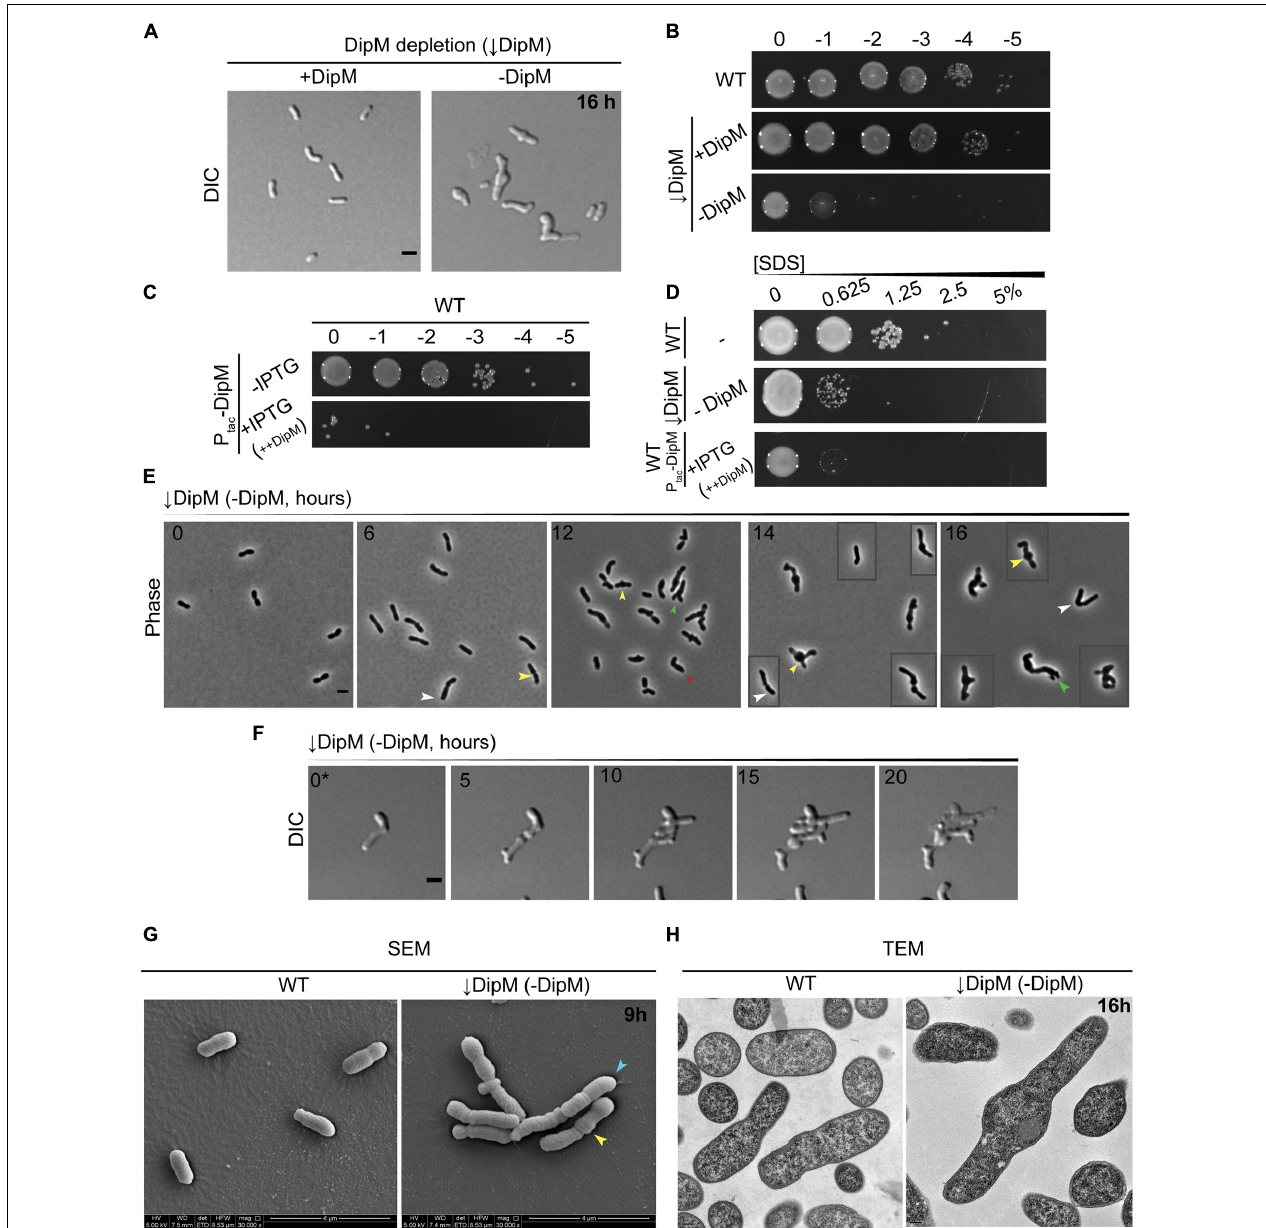
FIGURE 5 | dipM is essential in A. tumefaciens and depletion results in mid-cell bulging, inhibition of division, and ectopic pole formation. (A) DIC imaging of DipM replete ( ↓ DipM, +DipM; grown in the presence of IPTG) and depleted cells ( ↓ DipM, –DipM) for 16 h. Depletion of DipM ( ↓ DipM, –DipM) was achieved by washing the cells three times in LB and resuspending the culture (OD600 ∼ 0.1) in LB –IPTG. DipM depletion in LB results in mid-cell bulges and cell lysis. Scale bar = 2 µ m. (B) Spot viability assays of WT, DipM replete ( ↓ DipM, + DipM) and DipM depleted ((DipM, − DipM). Depletion of DipM ( ↓ DipM, –DipM) was achieved by washing the cells three times in LB before spotting on LB plates. (C) Spot viability assays of WT cells containing a plasmid encoded DipM under the control of the Ptac promoter in the absence (–IPTG, uninduced) and presence [+IPTG, induced (++DipM)] of inducer driving expression from the plasmid. ++DipM indicates that DipM is being overproduced. (D) Outer membrane integrity was assessed during SDS sensitivity. WT cells are more resistant than the DipM depletion ( ↓ DipM, –DipM) or DipM overproduction (+IPTG, ++DipM) strains. DipM was overexpressed (+IPTG, ++DipM) for 4 h before the SDS treatment and plated on LB plates. (E) Phase contrast images of DipM depleted cells (–DipM) for 0, 6, 12, 14, and 16 h in liquid LB. Arrowheads indicate main DipM depletion phenotypes: yellow arrowheads, mid-cell bulges; green arrowheads, tip-splitting events; white arrowheads, increased cell length; red arrowheads, bent/kinked cells. Boxed cells are additional examples of the field. Scale bar = 2 µ m. (F) Time-lapse microscopy of DipM depleted cells on LB-agarose pads for 20 h. 0* = DipM cells were pre-depleted for 6 h before starting the time-lapse to avoid overcrowding. Boxed cells are spliced from elsewhere in the field to provide additional examples of diverse morphotypes. Time in hours is indicated on the image. Scale bar = 2 µ m. (G) Scanning electron microscopy of WT and DipM depleted cells for 9 h (scale bar = 4 µ m). Arrowheads indicate main DipM depletion phenotypes: yellow arrowheads, mid-cell bulges; blue arrowheads, cell filamentation. (H) Thin section transmission electron microscopy of WT and DipM-depleted cells for 16 h. Scale bar = 0.2 µ m. All data collected for this figure was obtained from cells grown in